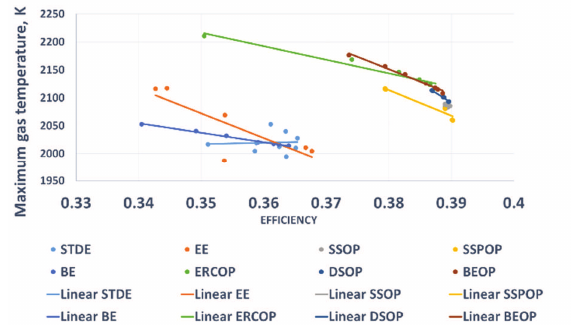
Fig. 18. Maximum gas temperatures for all designs